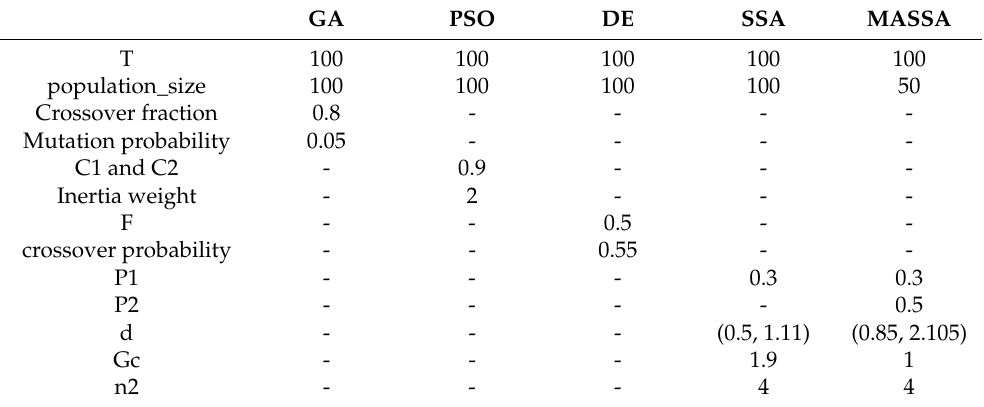
Table 4. Parameters setting of